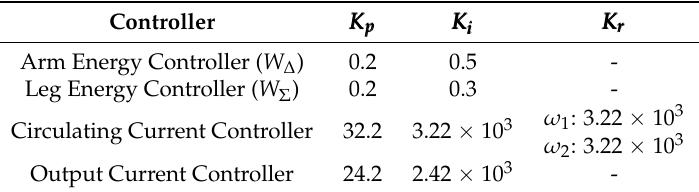
Figure 7. Laboratory prototype of the MMC STATCOM. Table 2. Control parameters of the experimental setup.